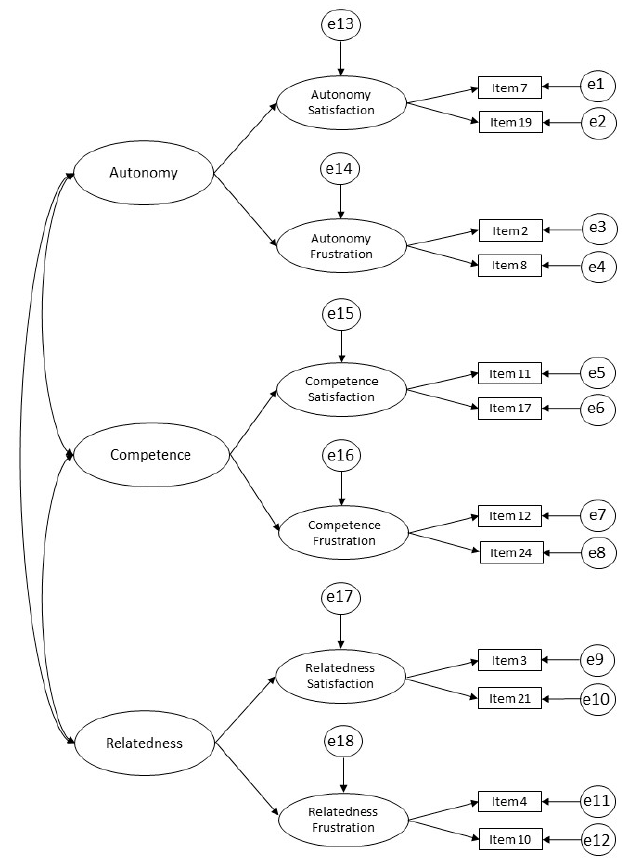
Figure A2. The 3-factor hierarchical model. e , error.